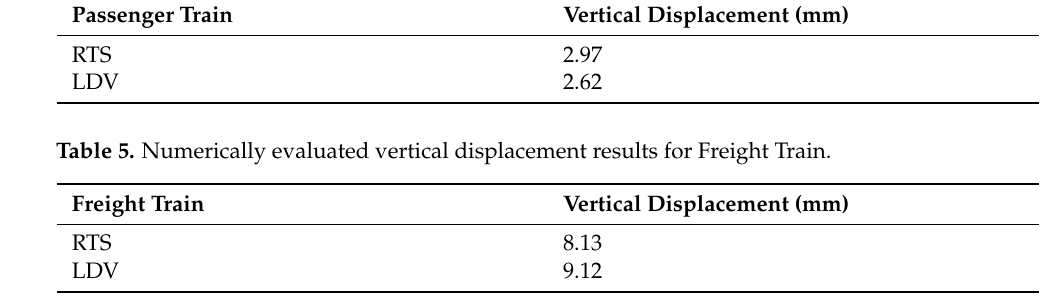
Table 5. Numerically evaluated vertical displacement results for Freight Train . Table 6. Calibrated measurement results from Minimate Plus measuring equipment for Passenger Train.